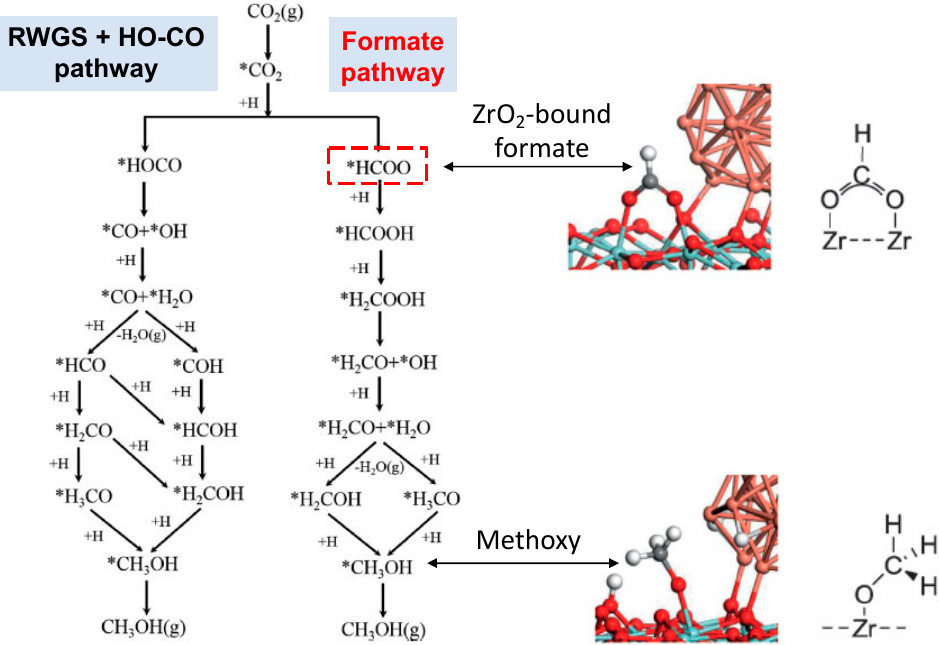
Figure 1. Reaction pathways proposed on Cu/ZrO 2 . (Adapted from reference [22], Kattel et al. J. Am. Chem. Soc. 138 (2016) 12440–12450 with permission, © 2016 American Chemical Society and from reference [24]. Larmier et al., Angew Chem. Int. Ed. Angew. Chem. Int. Ed. 2017, 56, 2318–2323 ©